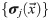
Reproducibility and accuracy of the RESUME maps.From left to right: a) RESUME maps of the spatial reference (HC1); b) voxelwise average, in the pool of subjects, of the {σj(x→)} maps spatially normalized to HC1; c) qMRI reference maps of HC1 obtained following [16] (for R2*, R1 and PD maps) and from the 8-echo GRE (for the QSM); d) voxelwise average, in the pool of subjects, of the {δj(x→)} maps spatially normalized to HC1. From top to bottom: 1) R2* map ([0 ∼ 50] s−1); 2) R1 map ([0 ∼ 2] s−1); 3) PD map ([0 ∼ 1] arbitrary units); 4) QSM ([−300 ∼ 300] ⋅ 10−9). Please note that the averages of {σj(x→)} (b) and {δj(x→)} (d) are shown with an enhancement factor of 20.